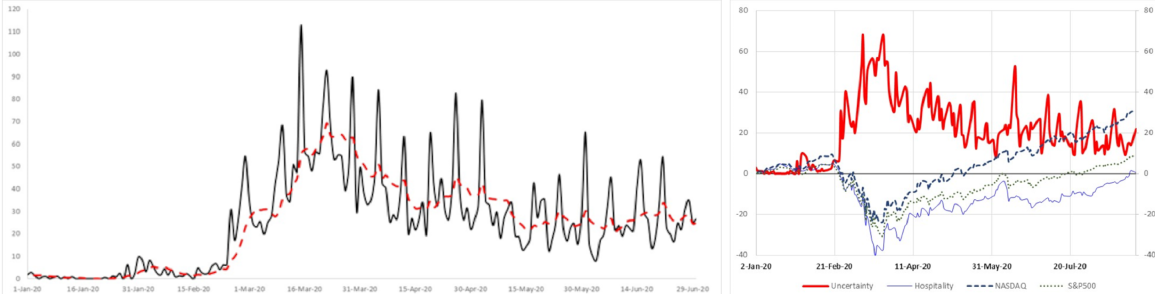
Fig 2. Evolution of the pandemic-driven uncertainty and market indices. (A) The dotted line is a one-week moving average of the index. The figure indicates that starting from the last week of February 2020, pandemic-driven uncertainty skyrocketed to record values. The figure includes 7-day-a-week observations. (B) The solid bold red line is Baker et al.’s daily index of uncertainty due to infectious diseases [46]. This uncertainty measure considers the frequency of U.S. newspaper articles that include terms related to economy, risk, financial market, uncertainty and epidemic. The uncertainty index observations correspond with the trading days on the stock exchange. The correlation between this form of uncertainty and variations in returns is 0.46 (t-stat = 4.66). Overall, the message of the figure is that high levels of uncertainty do not bode well for a quick recovery in the hospitality